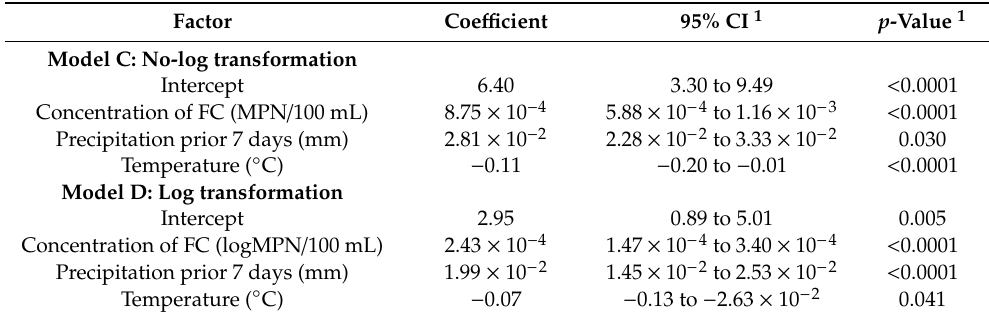
Table 4. Mixed-effects regression models between log- and log-transformed data of the concentration of E. coli collected from estuarine water samples from March 2016 to February 2017.